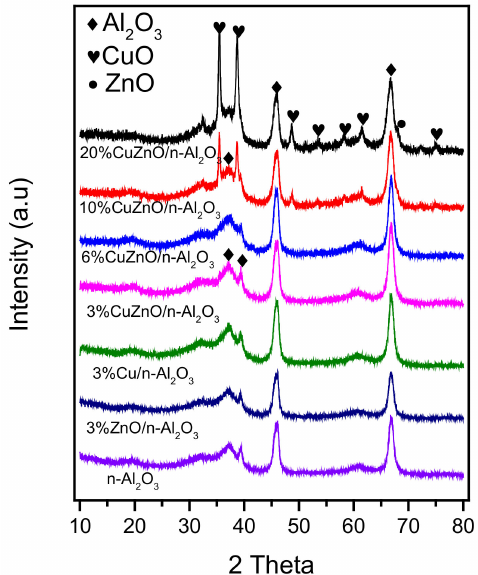
Figure 1. XRD patterns of n-Al 2 O 3 and catalyst